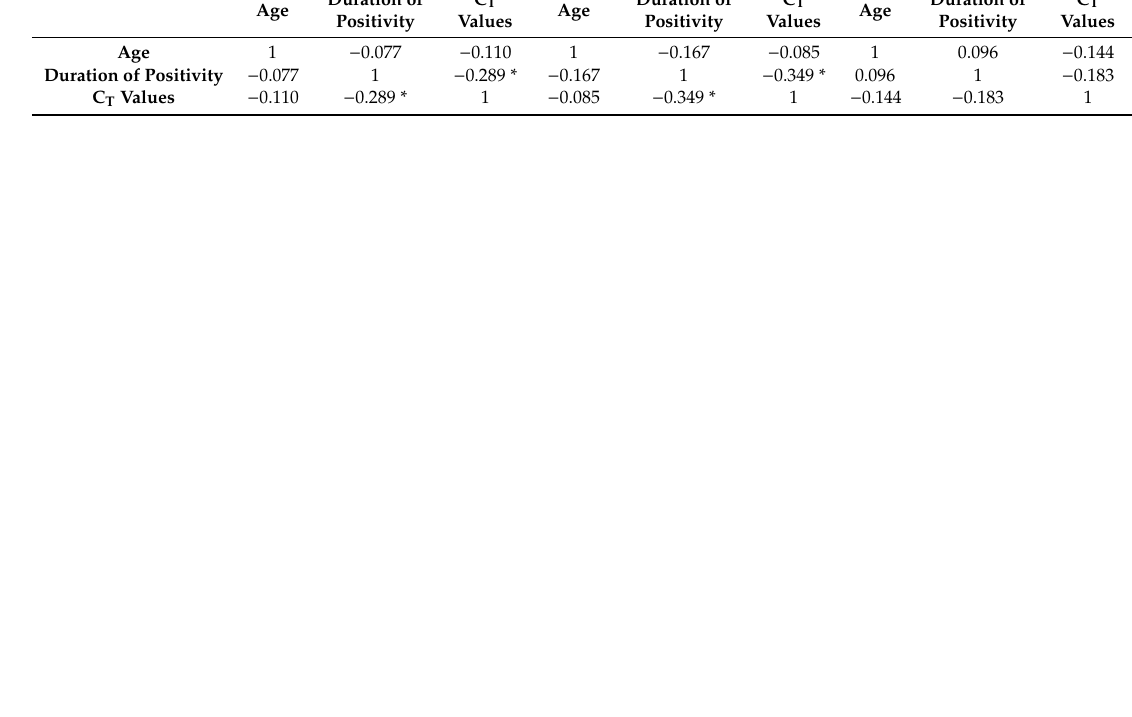
Figure 5. Scatterplot of C T N gene values at the first positive swab and the SARS-CoV-2 RNA persistence in naso-pharyngeal/oropharyngeal swabs per patient.